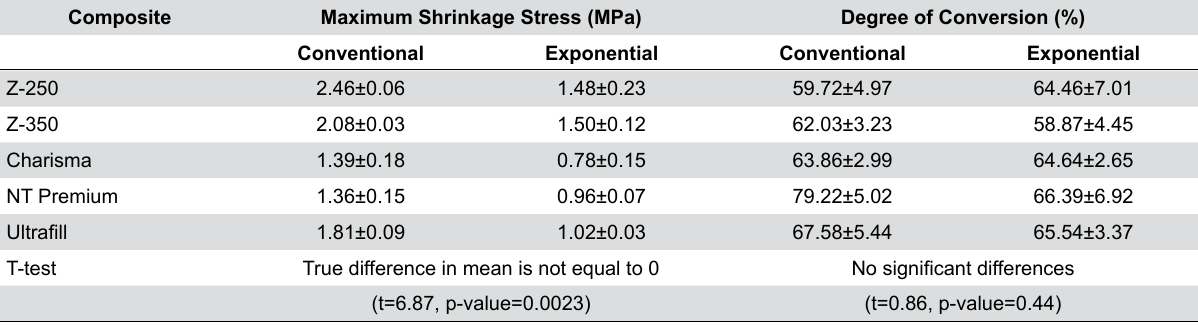
Table 1- Comparison of the shrinkage stress and degree of conversion for the conventional and exponential photoactivation